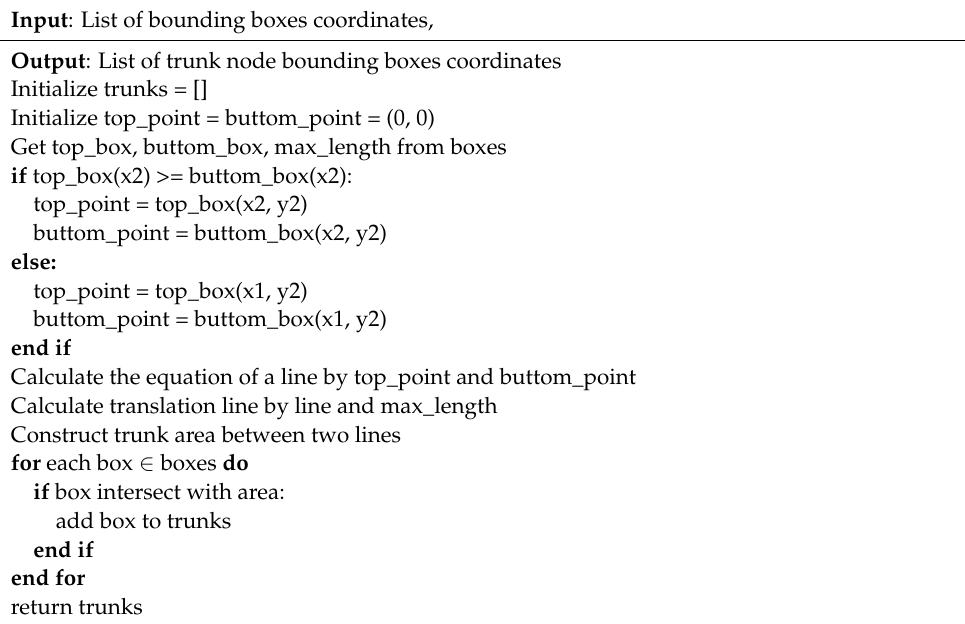
Algorithm 1. Trunk node extraction